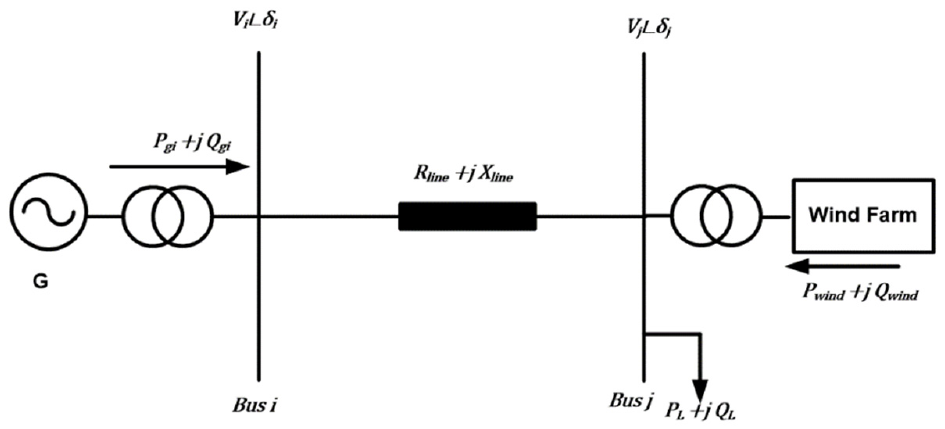
Figure 2. High-penetration wind farm system connected to Power system.